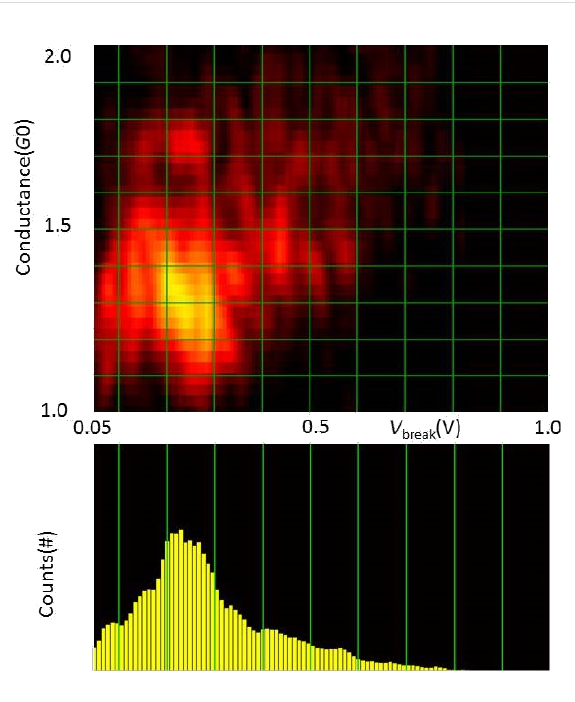
Figure 6: Density plot (top panel) and histogram (lower panel) collecting all breaking voltages for all chain lengths for Pt at 50 mV preparation